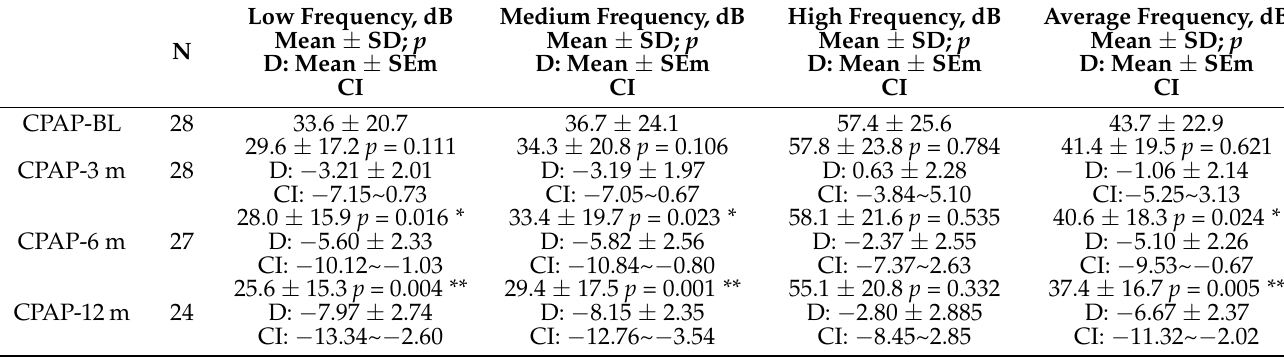
Table 3. The effect of CPAP therapy on hearing thresholds by a generalized estimating equation with adjusting potential confounding